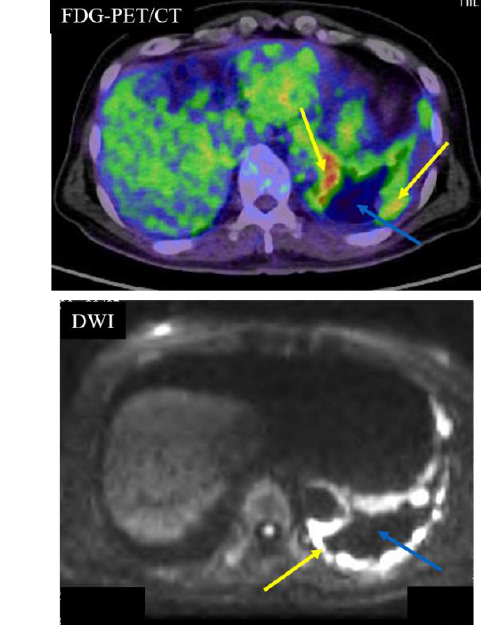
Figure 1. Case 1 — Malignant Pleural Mesothelioma (MPM). A 64-year-old male with MPM Figure 1. Case 1—Malignant Pleural Mesothelioma (MPM). A 64-year-old male with MPM (cT4N2M0). (cT4N2M0). The yellow arrows indicate the MPM. The blue arrows indicate pleural effusion. The yellow arrows indicate the MPM. The blue arrows indicate pleural e ff usion. Computed tomography Computed tomography (CT) showed left pleural thickness of the MPM. The apparent diffusion (CT) showed left pleural thickness of the MPM. The apparent di ff usion coe ffi cient (ADC) of the MPM coefficient (ADC) of the MPM was 0.84 × 10 -3 mm 2 /s (positive) and the ADC of the pleural fluid was was 0.84 × 10 − 3 mm 2 / s (positive) and the ADC of the pleural fluid was 3.95 × 10 − 3 mm 2 / s (negative). 3.95 × 10 -3 mm 2 /s (negative). Fluorodeoxyglucose (FDG)-position emission tomography (PET)/CT Fluorodeoxyglucose (FDG)-position emission tomography (PET) / CT showed partial accumulation showed partial accumulation (standardized uptake value (SUV)max: 12.39) of FDG on the MPM. (standardized uptake value (SUV)max: 12.39) of FDG on the